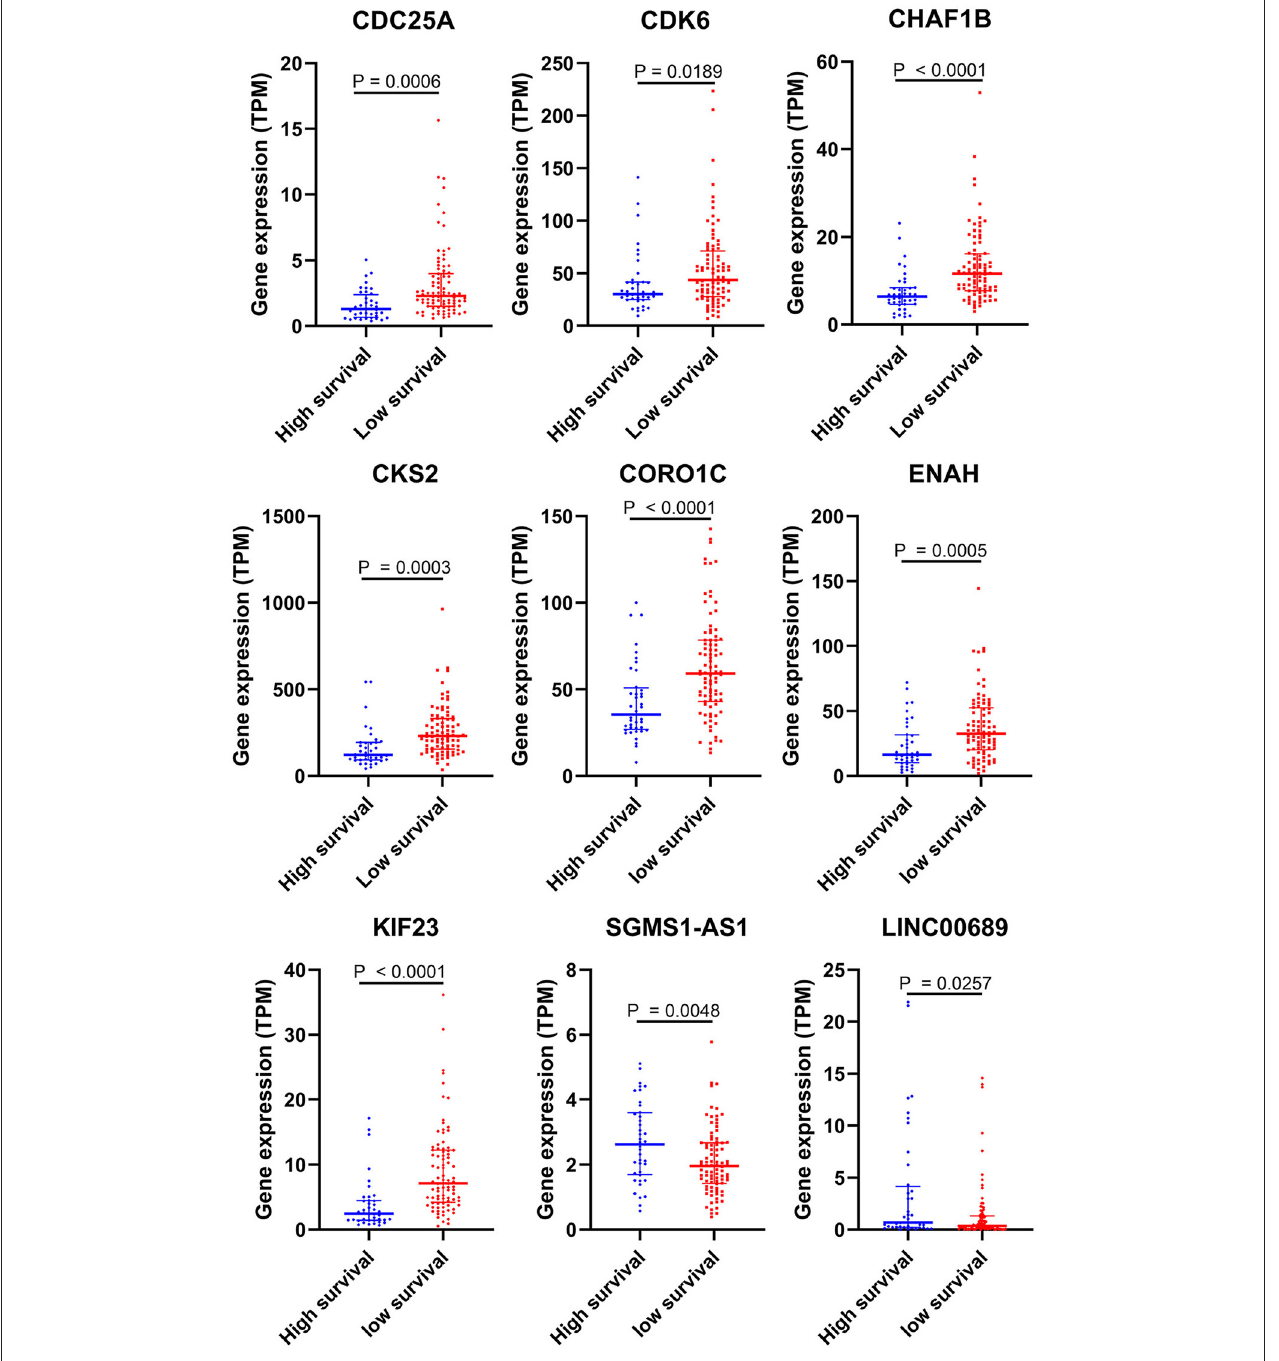
FIGURE 6 | Validation of DEGs in the risk model based on the EGA MPM dataset. The statistical analyses were performed by Students’ t- test with or without Welch correction according to the TPM of genes. analyses and the ROC curves showed that the risk model has great values to estimate the prognosis of MPM ( P < 0.001, AUC values = 77.0%, Figures 5F,G ). Also, the multivariate Cox analysis was performed to verify the identified potential independent prognostic factors according to the variates from